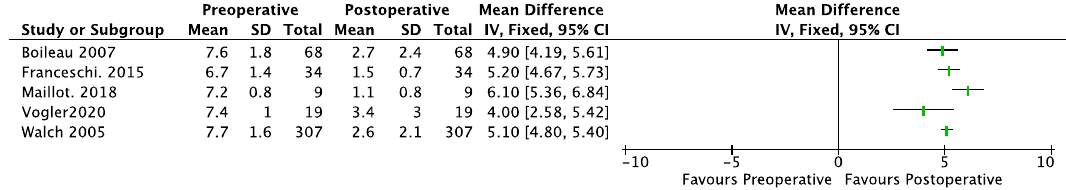
Figure 7. Funnel plot of comparison: VAS, outcome in BT. SE: Standard Error; MD: Mean Difference. 3.4. Shoulder Motion (Forward Flexion, External Rotation, Abduction) Regarding PCR, the results demonstrated wide improvements in forward flexion [15,16,22–25,28–30,33,40] (range, − 14°, 59.4°) and abduction [15,23,28] (range, 35.3°, 60.2°), and low improvements in external rotation [15,16,22,24,28–30,33,40] (range, 1°, 19.1°). In the BT group, the 5 studies demonstrated improvements in forward flexion [15,16,22,35,38] (range, 2°, 27.9°) and negative influence over external rotation [15,16,22,35,38] (range, − 8.6°,7°). Only 1 study (randomized control trial = 1) on abduction [15] reported an increase of 10° (range, − 8.8°, 28.8°). 3.5. Acromiohumeral Distance (AHD) For PCR ‐ BT, the results of 5 studies (cases series = 5) [27,28,31,32,34] including 198 shoulders showed diminution of AHD at the last follow ‐ up (range, − 0.8–3 mm). Results from 4 BT studies (cases series = 3, case–control = 1) [35,37–39] with 416 shoulders showed diminution of AHD at the last follow ‐ up (range, − 4, − 1.1). 3.6. Complications Thirteen studies reported complication and revision rates. In the BT group, 7 of the 8 studies (cases series = 3, case–control = 2, randomized control trial = 1, prospective cohort study = 1) [15,22,35–39] reported only 1 complication, a postoperative acute infection which was successfully cleared with antibiotics and arthroscopic irrigation [35]. Reported conversion rates were one hemi ‐ arthroplasty at 20 months for severe glenohumeral arthri ‐ tis [15], 1 RSA at 36 months for a missed preoperative osteoarthritis diagnosis [35], and 5